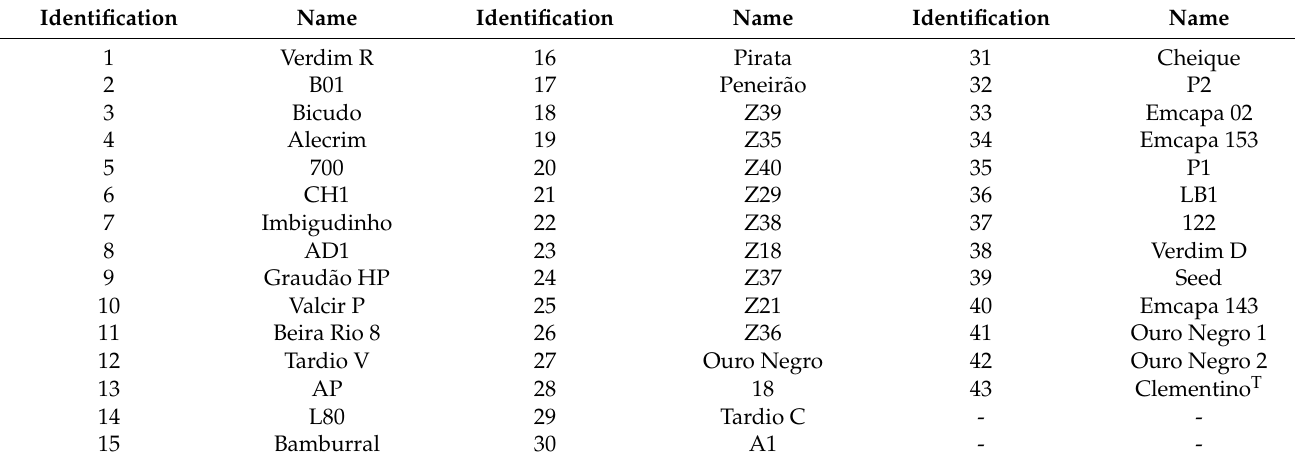
Table 1. Identification of the 43 genotypes of Coffea canephora cv. Conilon in Nova Ven é cia, ES,